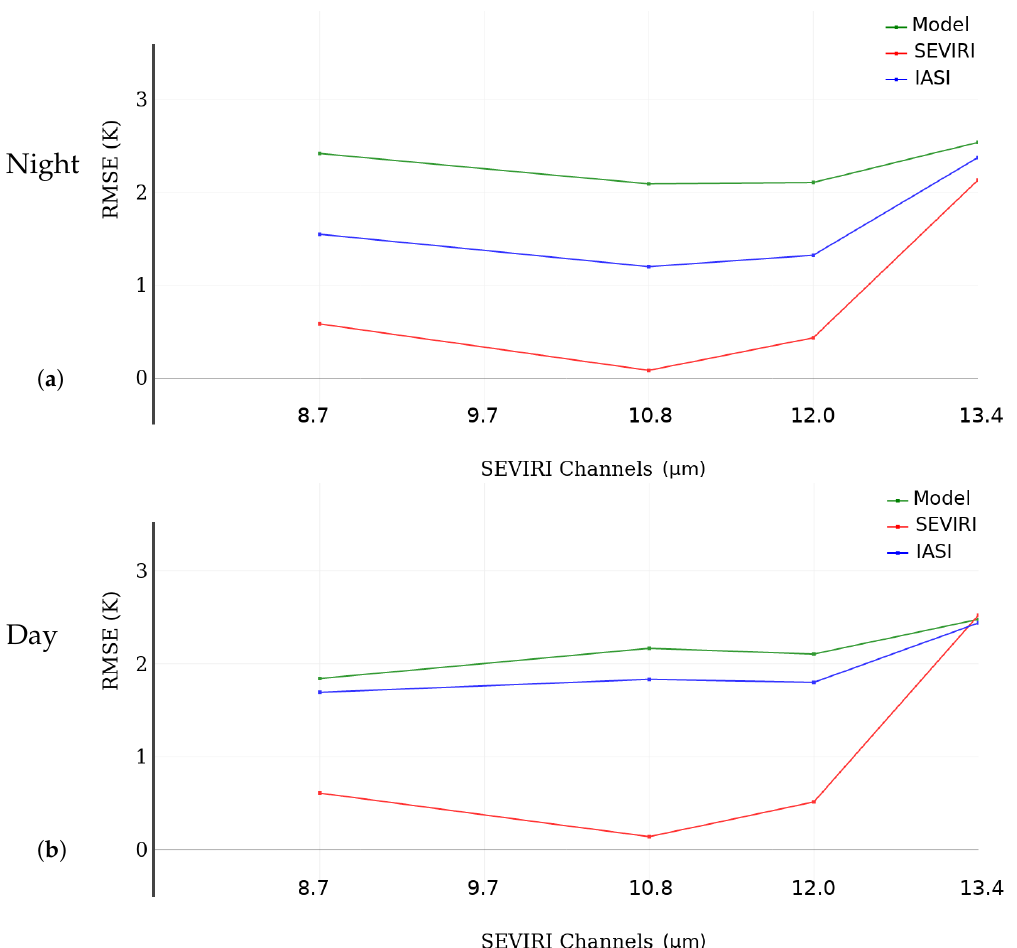
Figure 12. nighttime ( a ) and daytime ( b ) root mean square errors related to simulations of SEVIRI brightness temperatures using model LST (green line), SEVIRI LST (red line) and IASI LST (blue line).